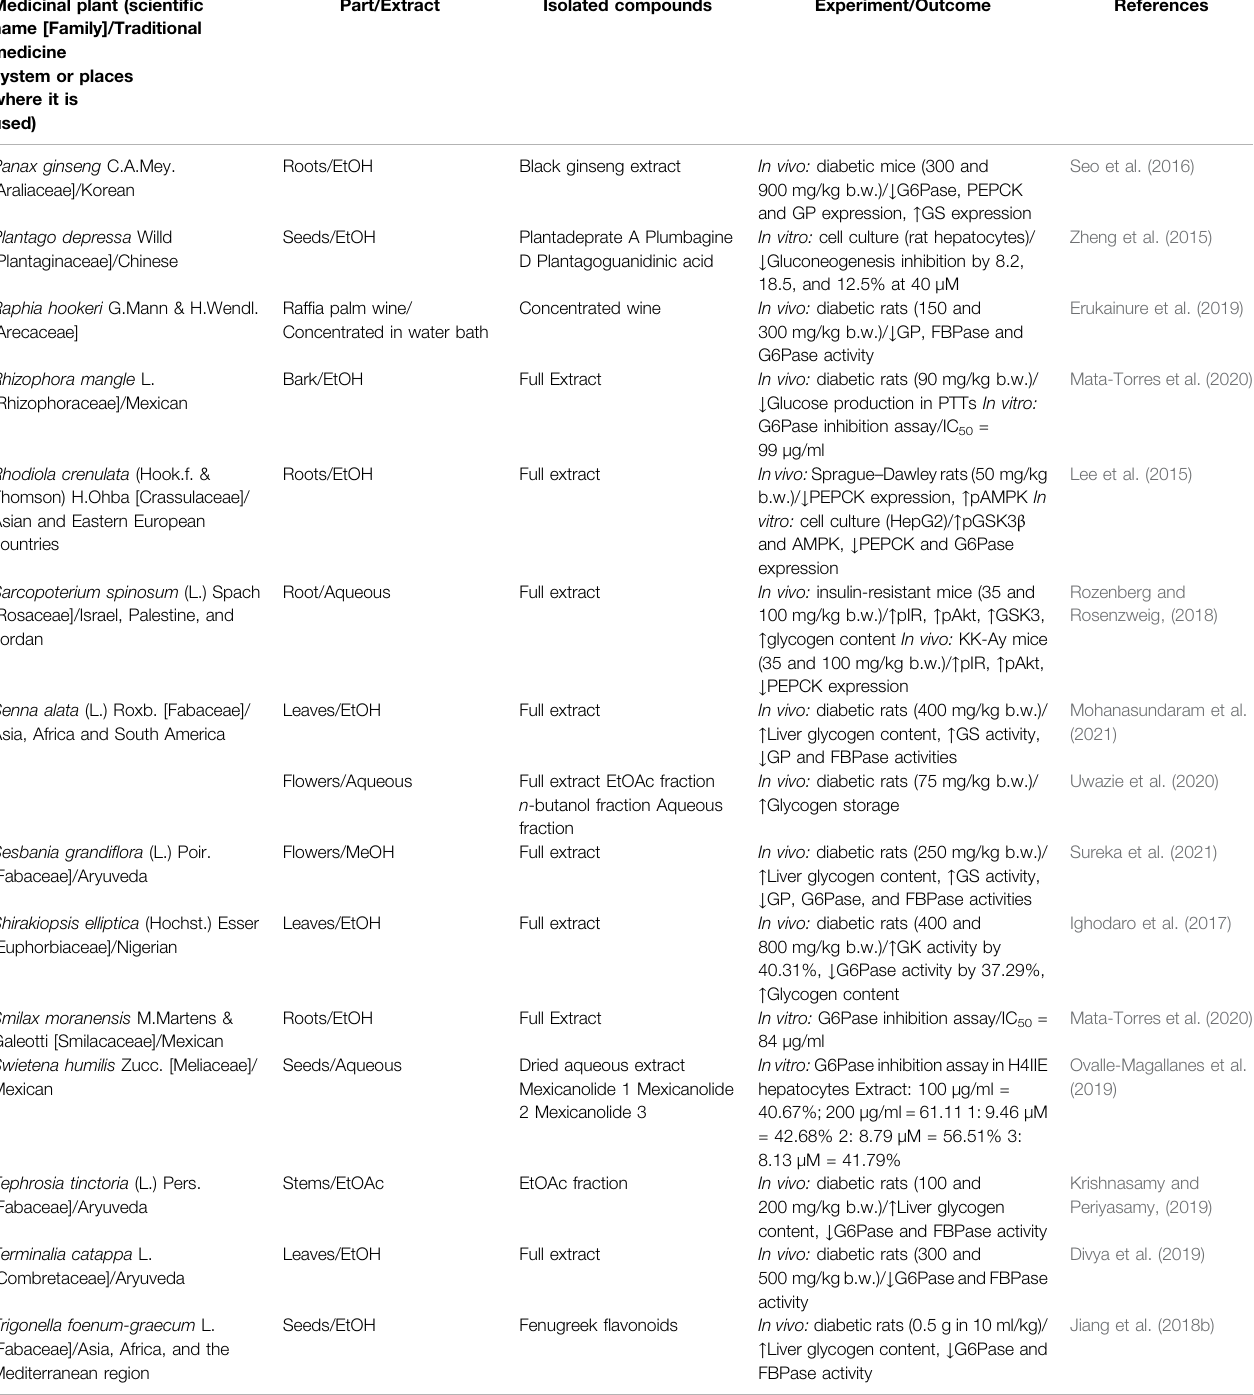
Medicinal plant (scienti fi c name